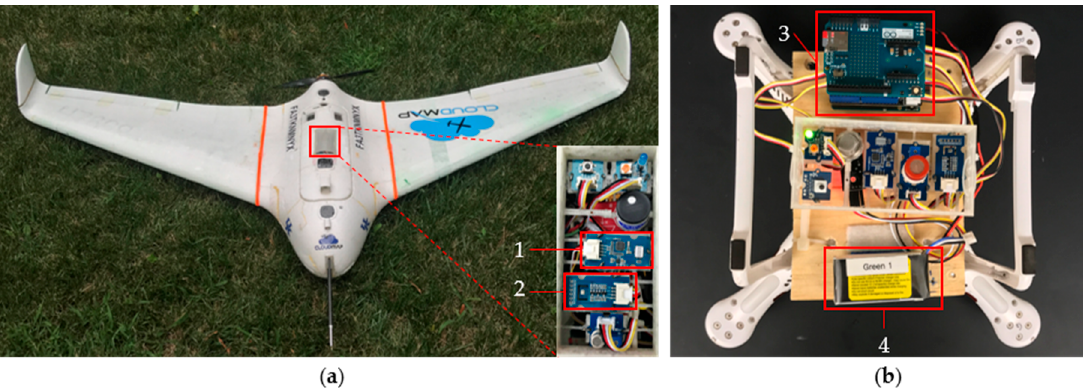
Figure 3. Unmanned aerial vehicles (UAV) carrying gas sensing packages. ( a ) Skywalker X8 with (1) MiCS-6814 and (2) BME280. ( b ) DJI P3 frame with (3) Arduino UNO Microcontroller with V2 Base Shield and Arduino Wireless SD Shield, and (4) battery.